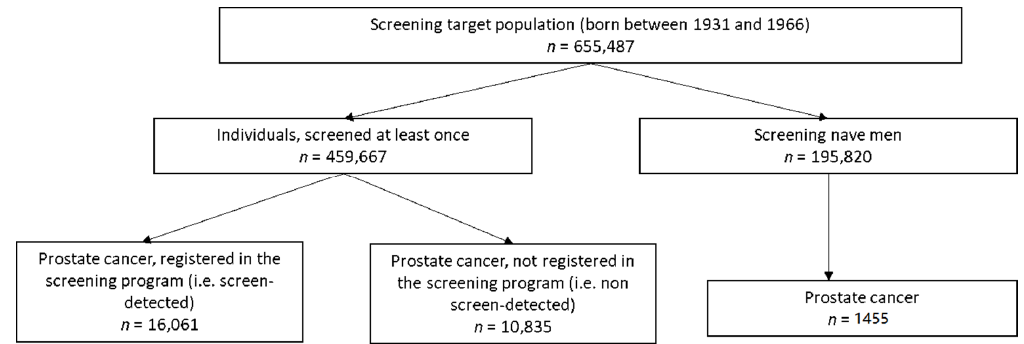
Figure 2. Prostate cancer diagnosis among individuals aged 50 to 74 years in Lithuanian between 2006 and 2015.